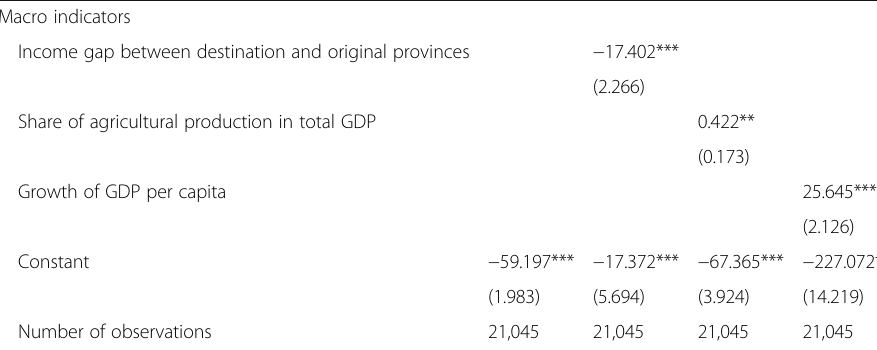
Table 2 Random-effect Tobit regression (Continued) Macro